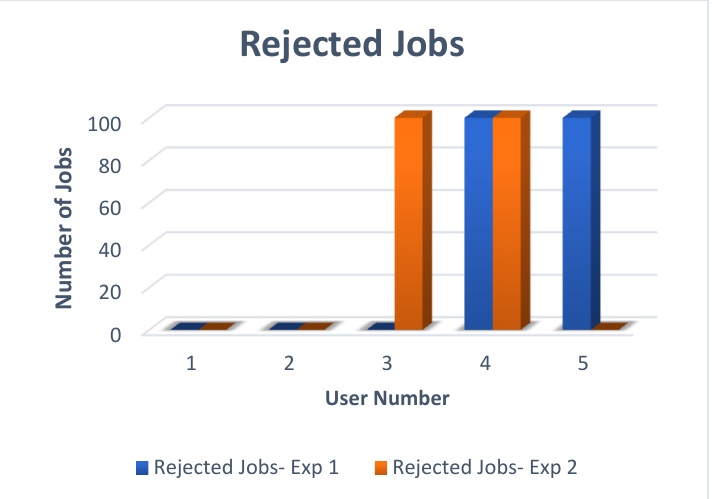
Figure 9. Time Required to Process Both sections—Experiment 1.